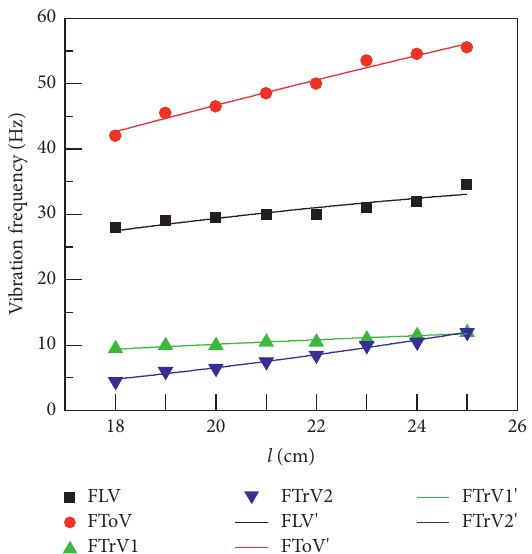
Figure 8: Rock natural frequency curve